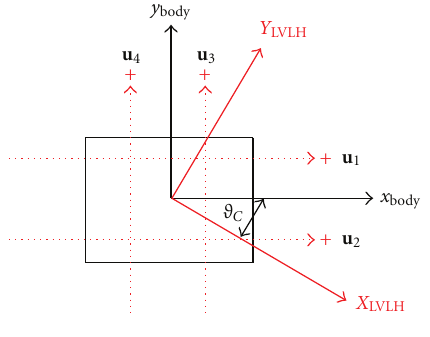
Figure 9: Locations of controls for the planar assembly.